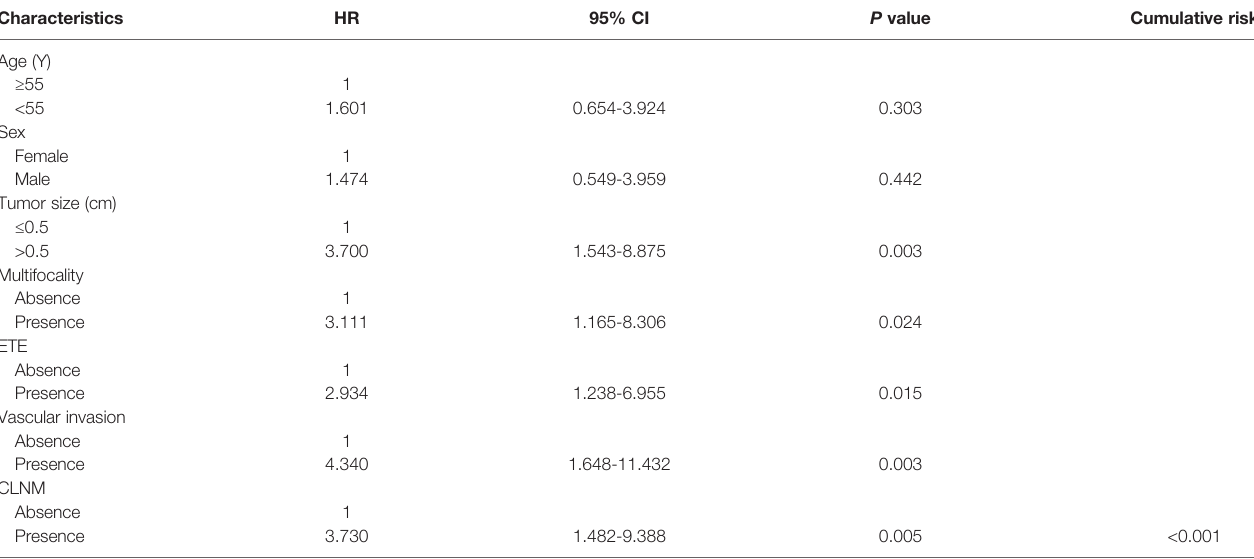
TABLE 2 | Cox proportional hazards model demonstrating factors associated with recurrence-free survival in PTMC patients.